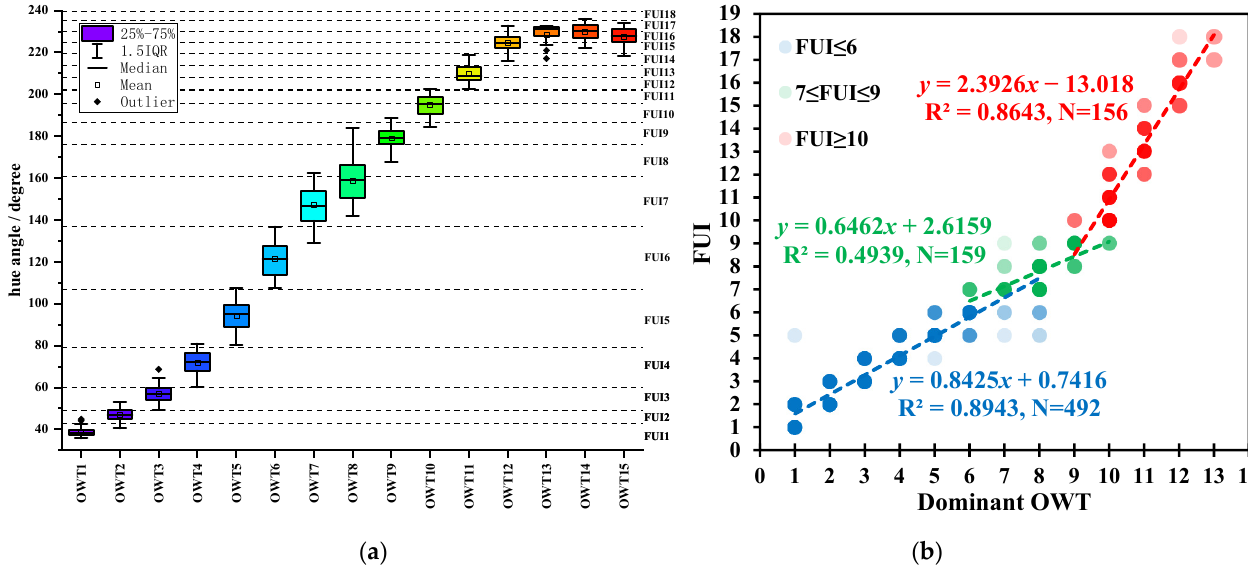
Figure 13. ( a ) Hue angle distribution of each U-OWT class from the PACE synthetic data set ( N = 714). The separations of adjacent FUI are shown with dashed lines. ( b ) Scatterplot of data pairs of FUI and U-OWT dominant OWT from the in situ measurements collected from 612 sites covering coastal and oceanic waters around the world ( N = 612) and 195 sites in coastal and oceanic waters off China ( N = 195). The points are plotted with 85% transparency to show the data density. FUI ≤ 6, 7 ≤ FUI ≤ 9, and FUI ≥ 10 represent oligotrophic, mesotrophic, and eutrophic waters, respectively [37] .